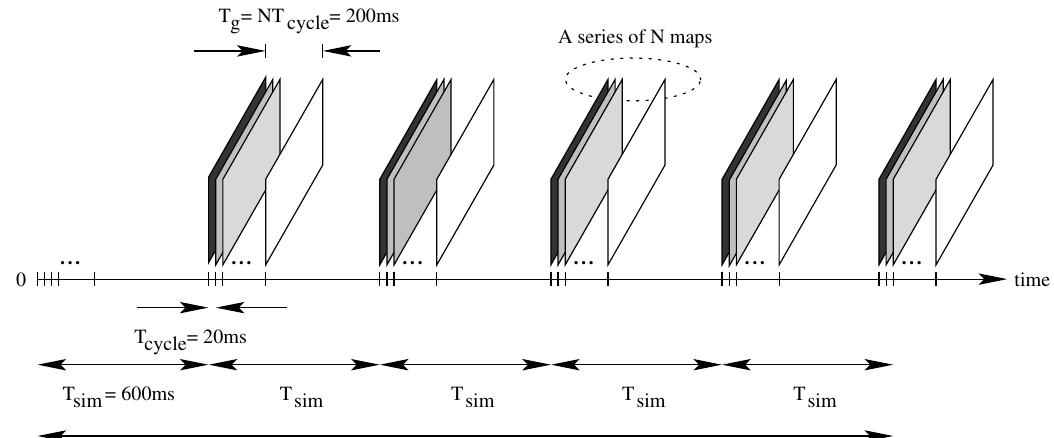
Figure 12. The asynchronous communication scheme: The path planner runs once every T cycle = 20 ms even if the data-fusion system generates a set of maps every T g = 200 ms. As in the synchronous case, during each run, the path planner generates an expansion tree of depth 5 (and spanning a total lookahead time of 3 s in the future). Unfortunately, the path planner runs N = 200/20 = 10 times for every single data-fusion run. Consequently, the data-fusion system must generate, and transfer to the planner, a set of ( N · H ) , i.e., 10 · 5 = 50, maps representing the environment. Maps belonging to the same tree level (a series of maps) have a time difference of 20 ms. Maps belonging to the same expansion tree (a set of maps) have a time difference of 600